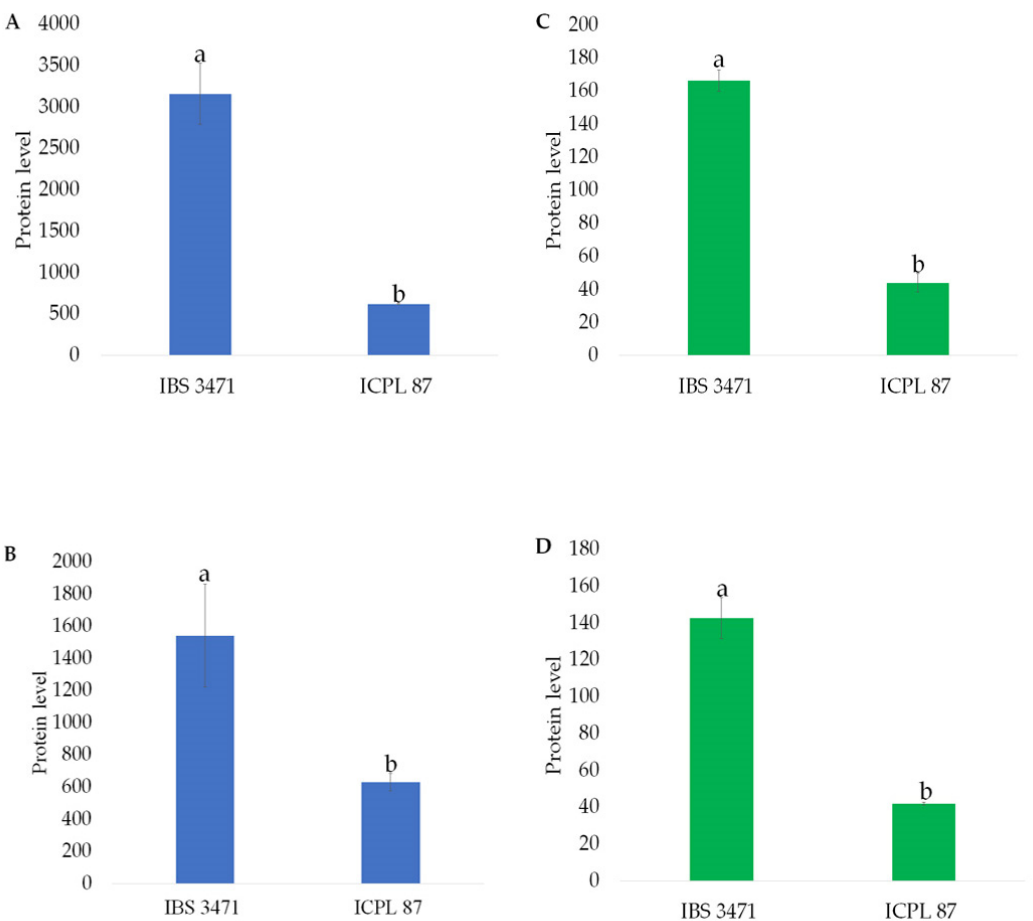
Figure 5. Protein levels in C. scarabaeoides (IBS 3471) and C. cajan (ICPL 87) leaves. ( A ) Cysteine proteinase inhibitor at the vegetative stage. ( B ) Cysteine proteinase inhibitor at the flowering and podding stage. ( C ) Lectin-domain containing receptor kinase at vegetative stage. ( D ) Lectin-domain containing receptor kinase at the flowering and podding stage. Values labelled with different letters are significantly different at p < 0.05 ( A and B ) and p < 0.01 ( C and D ) (Tukey’s HSD test). All data are means ± standard errors ( n = 2 for vegetative stage and n = 3 for flowering and podding stage).